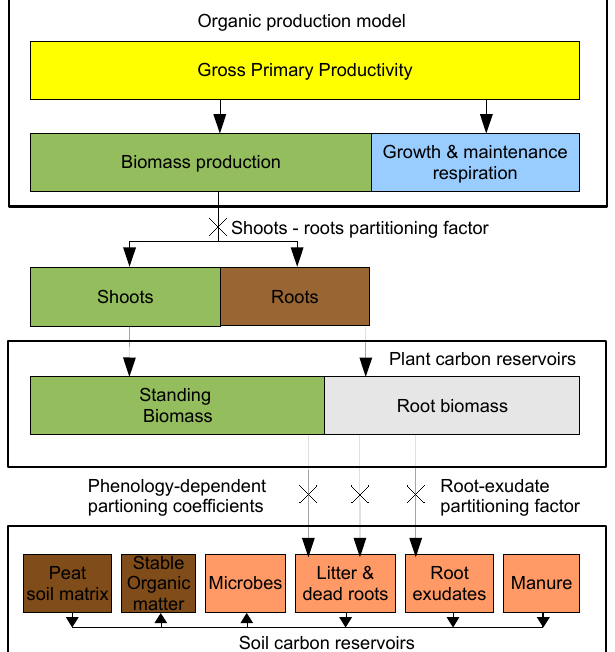
Figure 2. Schematic of the carbon partitioning simulated by